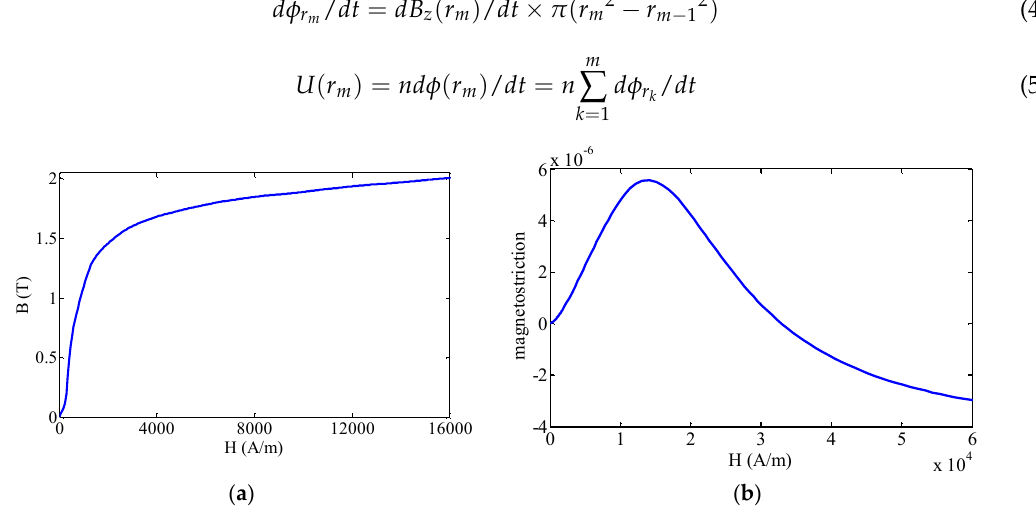
Figure 1. The magnetization curve and the magnetostriction curve of the steel pipe. ( a ) The magnetization curve; ( b ) the magnetostriction curve.